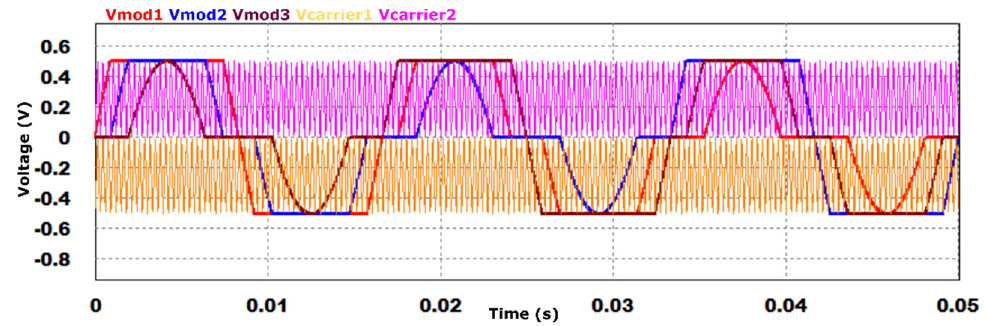
Figure 11. Reconstructed modulating signals and carrier signals.